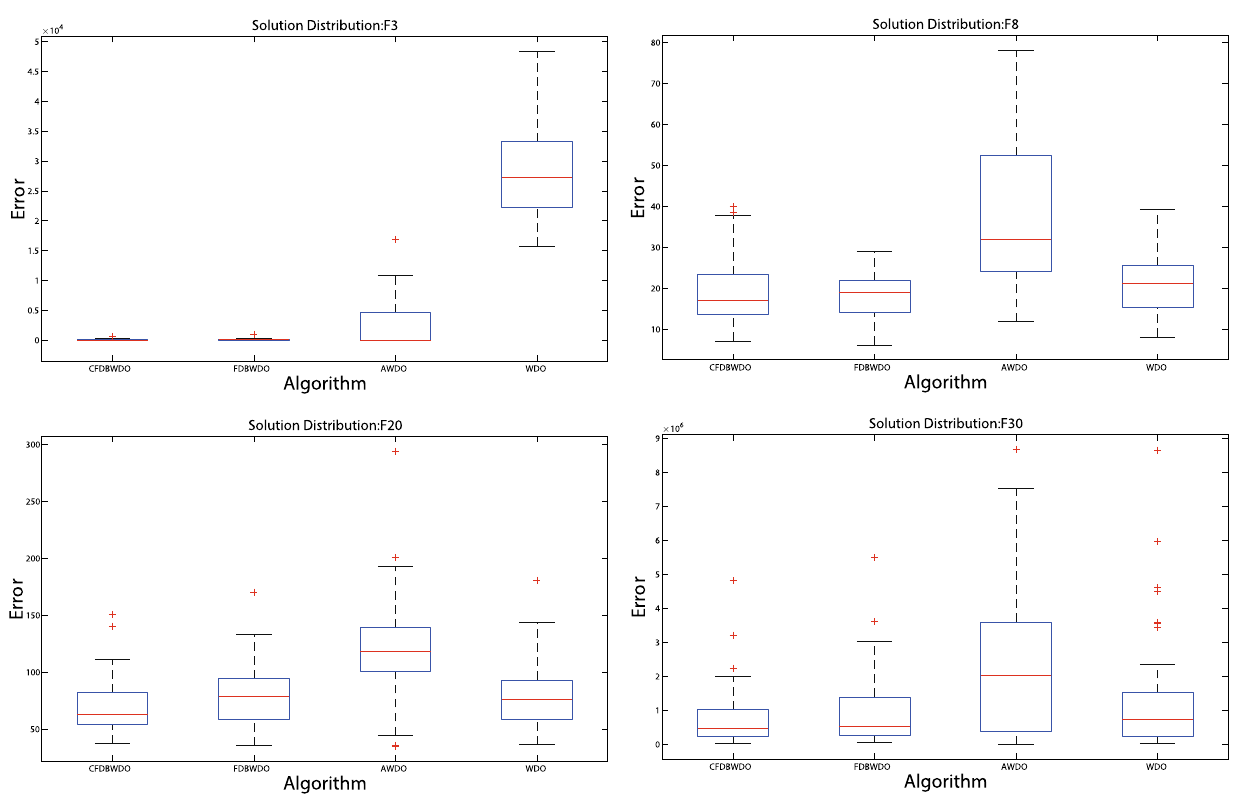
Fig. 3 Box-and-whisker diagrams of four WDO variants on F3, F8, F20 and F30 with 10 dimensions